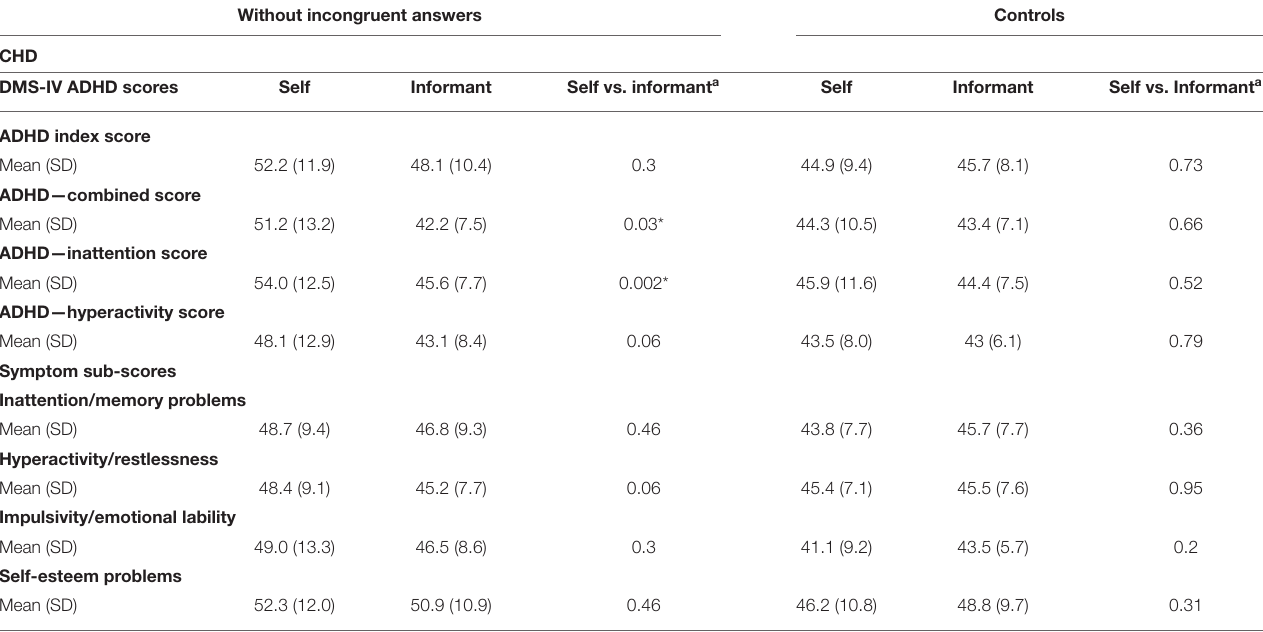
TABLE 6 | Congenital heart defect informant vs. congenital heart defect self-evaluation. Without incongruent